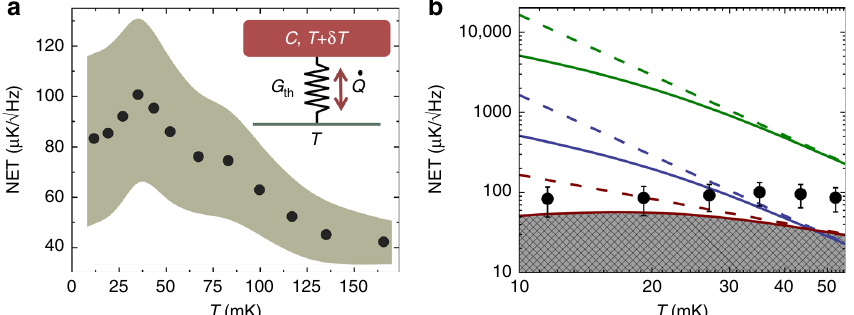
p ffiffiffiffiffi S at different bath temperatures. The symbols are the Fig. 3 Temperature fl uctuations in equilibrium. a Measured low-frequency fl uctuations NET ¼ T measured data (both in a and b ) with the mean instrumental background noise subtracted as described in the Methods section. The shaded area covers the uncertainty in this subtraction process. The inset shows schematically the thermal model including the absorber with fi nite heat capacity C coupled to the heat bath at temperature T via thermal conductance G . b Comparison of the data to the predicted noise-equivalent temperature NET, now on a th logarithmic scale, in the absence ( α ¼ 0, dashed lines) and presence ( α ¼ 10 (cid:2) 4 , solid lines) of photon contribution assuming a normal-metal absorber. The ffiffiffiffiffiffiffiffiffiffiffiffiffiffiffiffiffiffiffiffiffi q error bars on the experimental points are based on the same uncertainty as in a . Red lines show the fundamental noise-equivalent temperature in p ffiffiffiffiffiffiffiffiffi T 2 = G equilibrium NET , which is the required NET of the detector to observe a photon 2 k , and blue and green lines demonstrate NET ¼ δ ϵ = CG th eq ¼ B th with energies δ ϵ ¼ 1 K ´ k and δ ϵ ¼ 10 K ´ k , respectively. Then NET = NET gives the expected signal to noise ratio of the experiment. B B eq